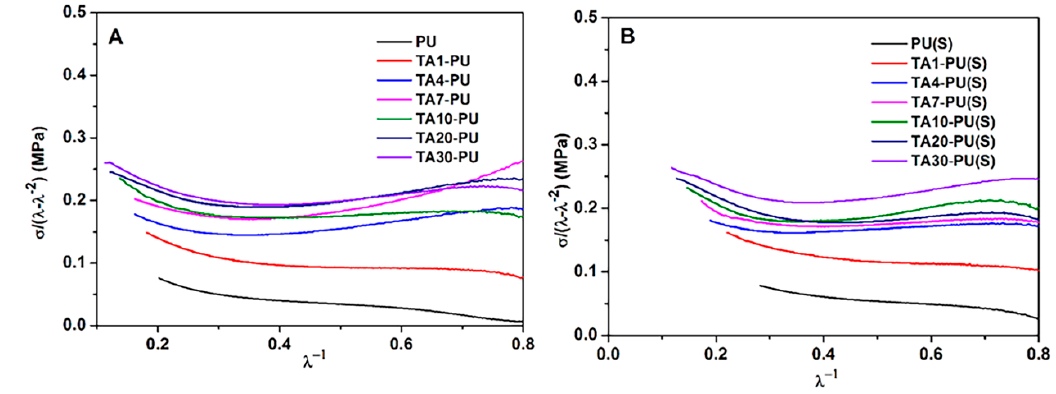
Figure 5. Mooney–Rivlin curves of pure PU and TA–PU hydrogels at as-prepared ( A ) and swelling equilibrium ( B ) states.